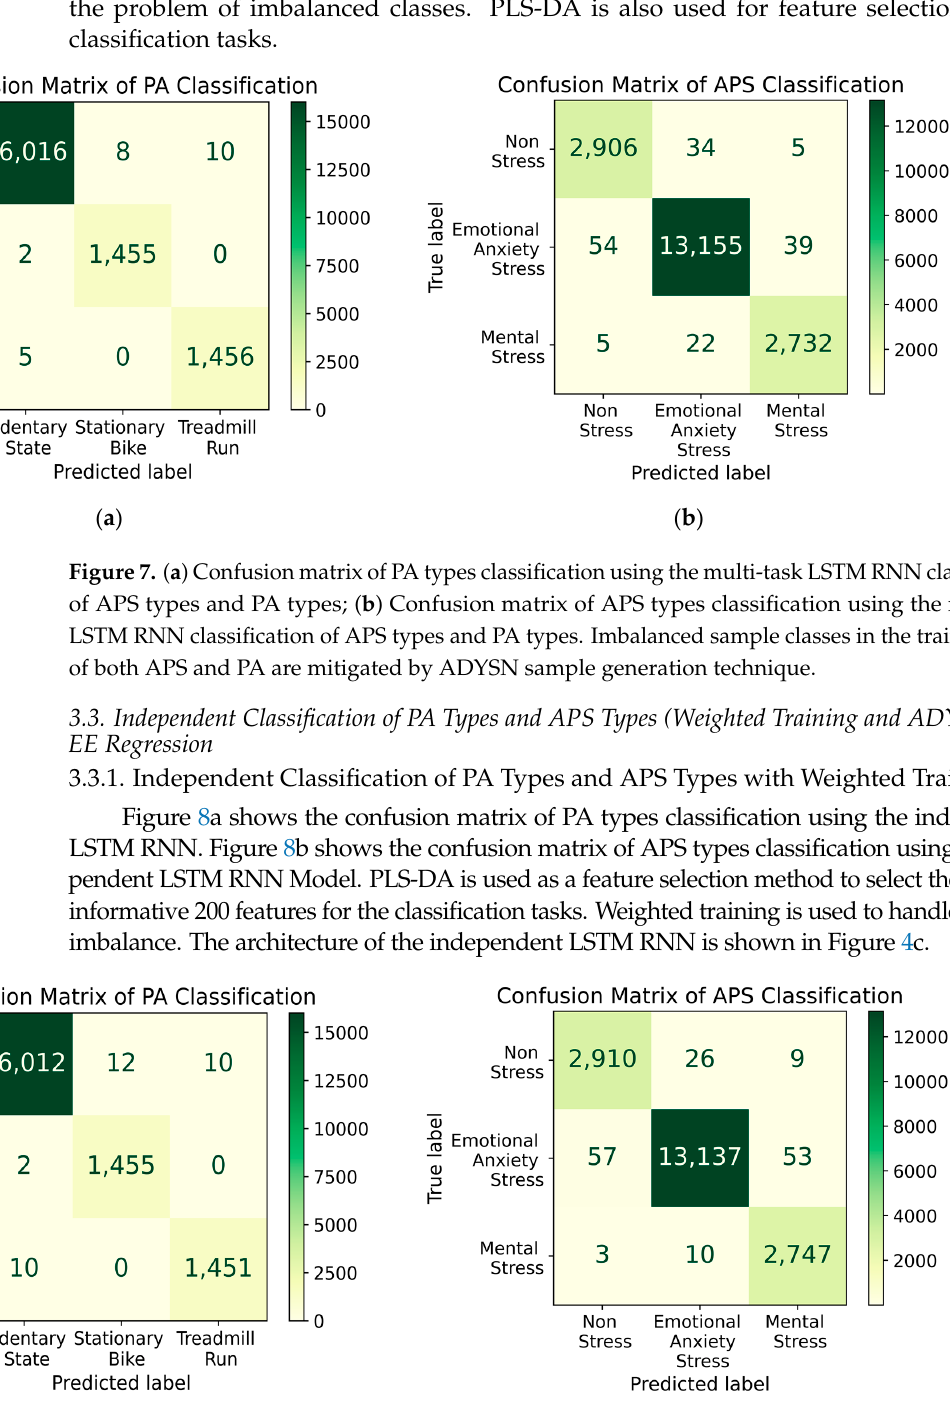
Figure 6. ( a ) Confusion matrix of PA types classification using the multi-task LSTM RNN classifi- cation of APS types and PA types (class imbalance mitigated by weighted training); ( b ) Confusion matrix of APS types classification using the multi-task LSTM RNN classification of APS types and PA types (weighted training).